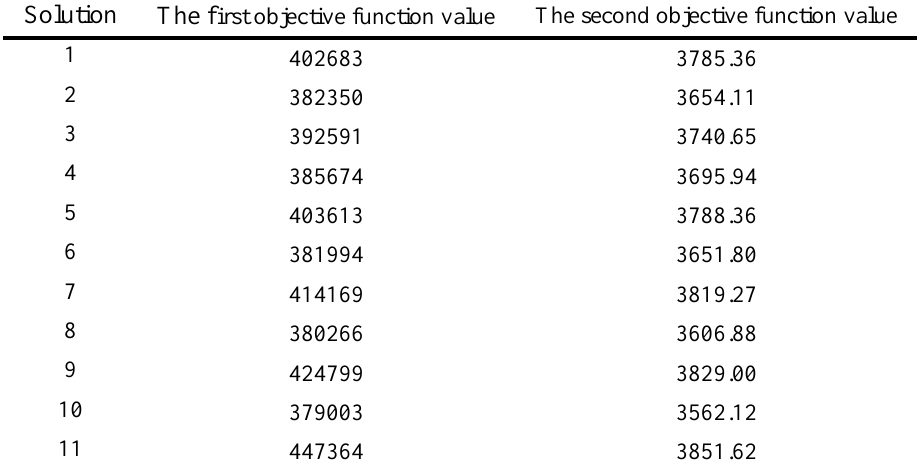
Table 10. The computational results associated with the first and second objective functions and for non-dominated points.